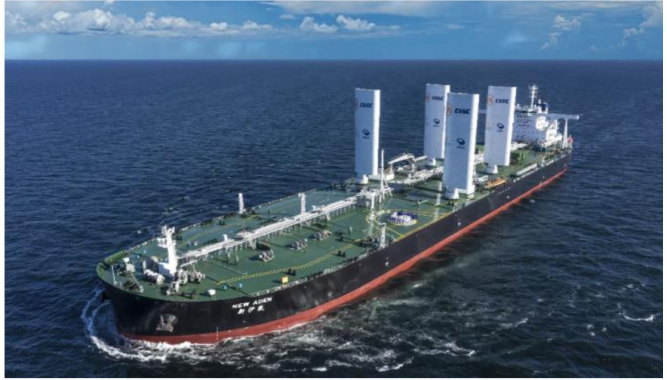
Figure 7. VLCC “NEW ADEN”.